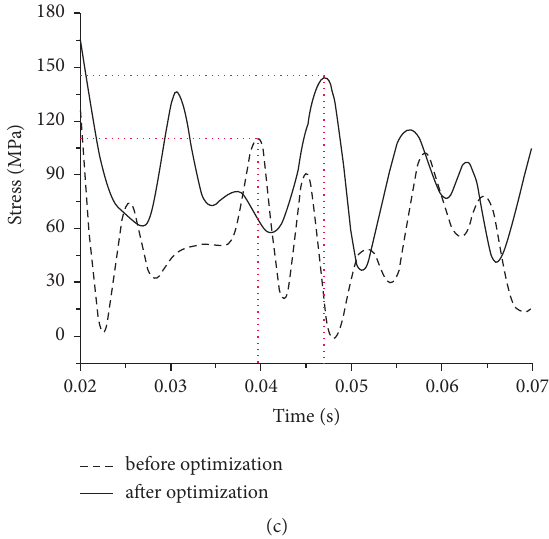
Figure 11: After sudden unloading, the stress cloud diagram and curve of the upper beam before and after optimization. (a) Stress cloud diagram of upper beam before optimization. (b) Stress cloud diagram of upper beam after optimization. (c) Stress curve of upper beam before and after